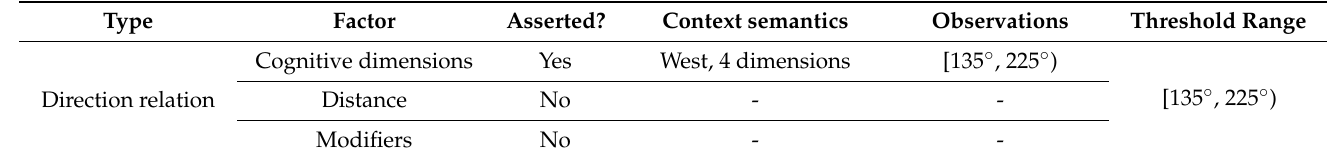
Table 5. Semantic analysis based on supervaluation of spatial assertion of Hyland Hotel.